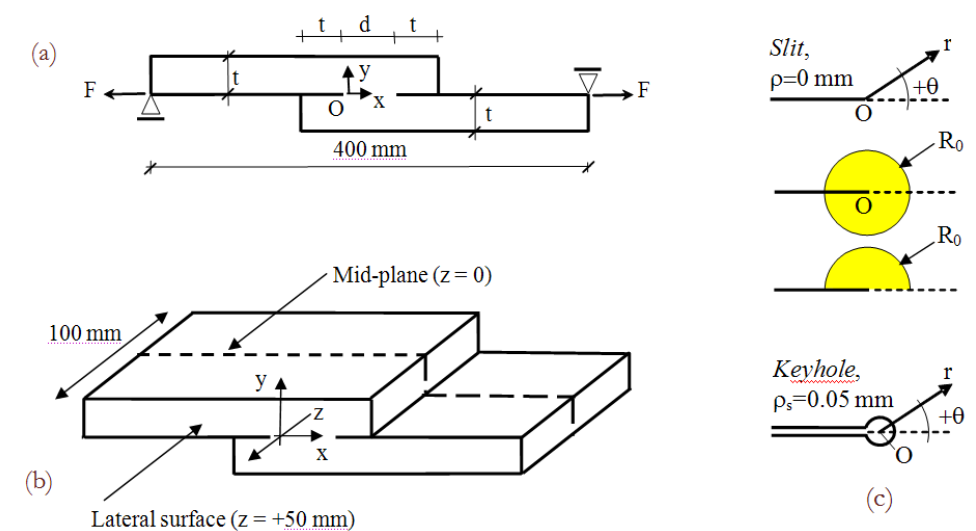
Figura 10: Giunto a sovrapposizione. Modello bidimensionale avente l’origine del piano x-y posizionato in corrispondenza della radice (a); modello tridimensionale con coordinata z=0 nel piano medio del giunto (b); volumi di controllo per i modelli con  =0 e modello con keyhole (c). Tensione nominale sempre riferita alla componente membranale,  nom